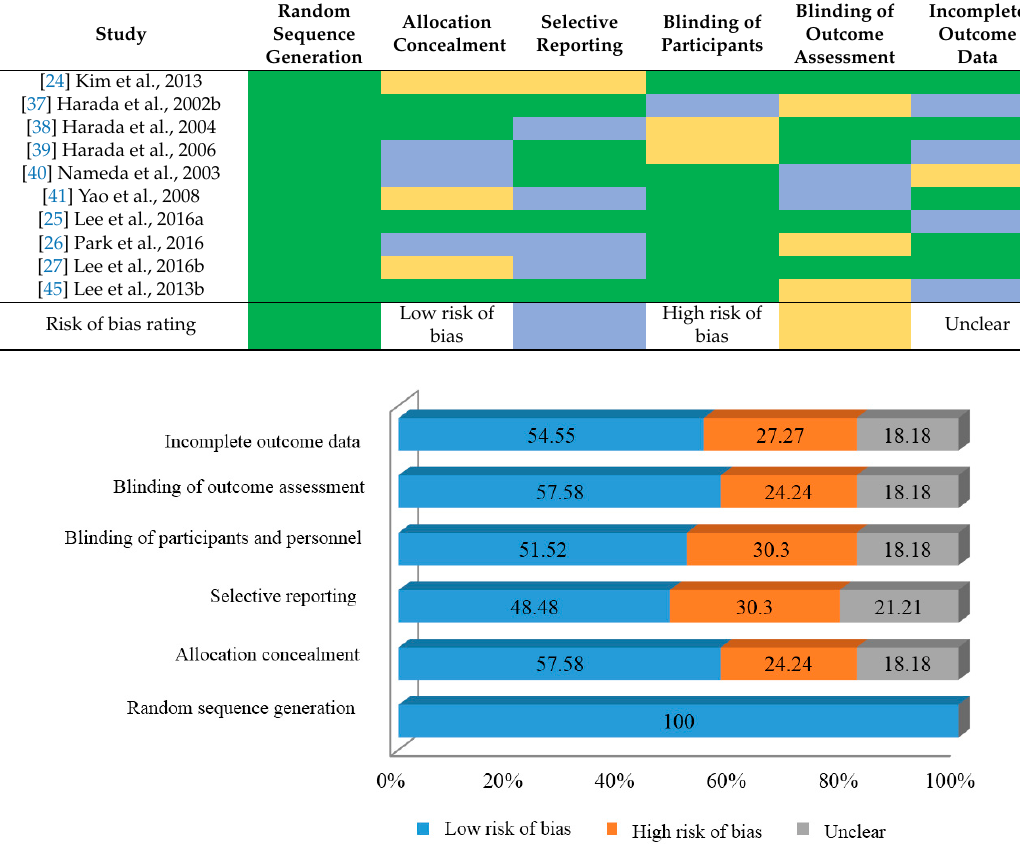
Table 3. Summary of standardized mean difference (SMD) comparison between control and S. crispa groups.